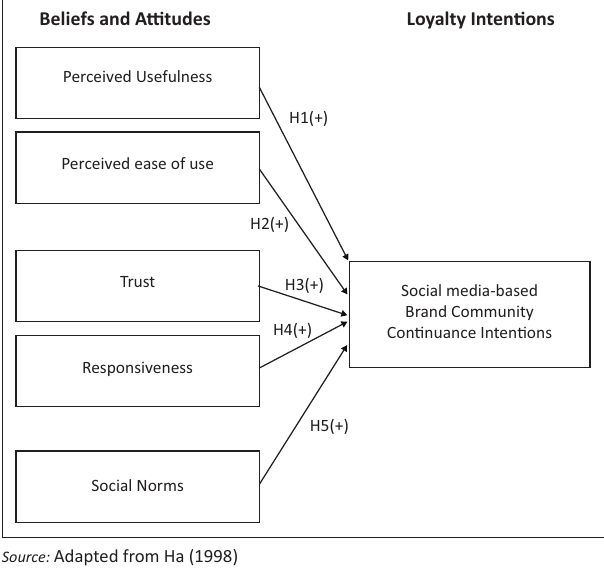
FIGURE 1: Proposed online brand community loyalty model based on the theory of reasoned